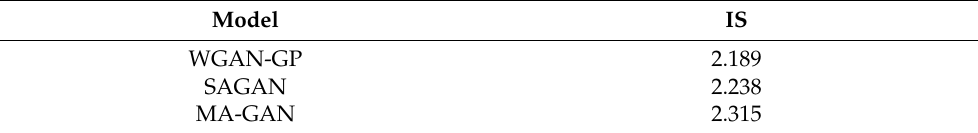
Table 8. The IS of different models on CelebA. Model IS